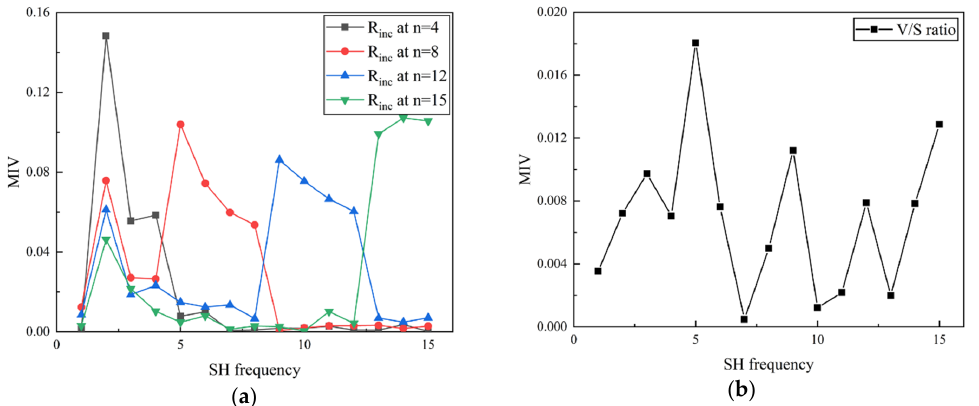
Figure 7. Mean impact va;ue (MIV) results: ( a ) R inc at different RLS; ( b ) V/S ratio.